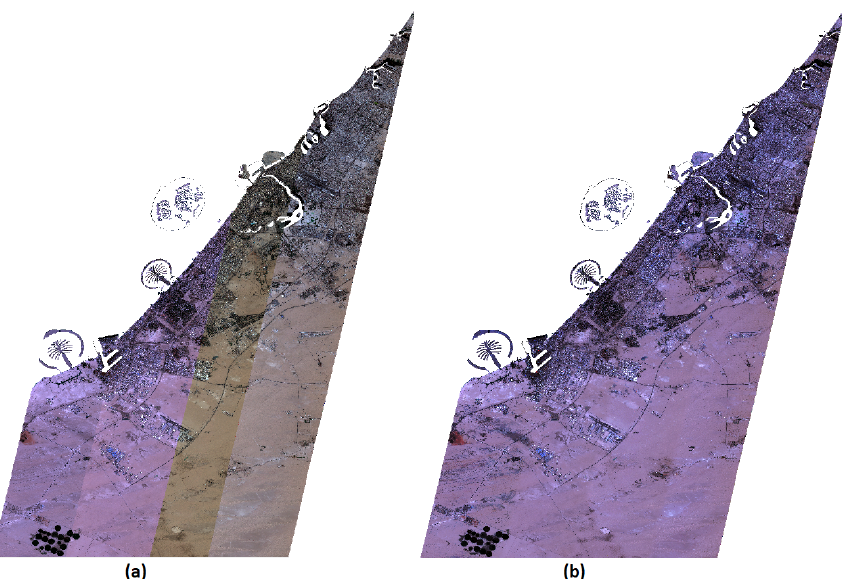
Figure 6. ( a ) Initial satellite tiles. ( b ) The color balanced mosaic output in DubaiSat-2 images using the proposed approach.